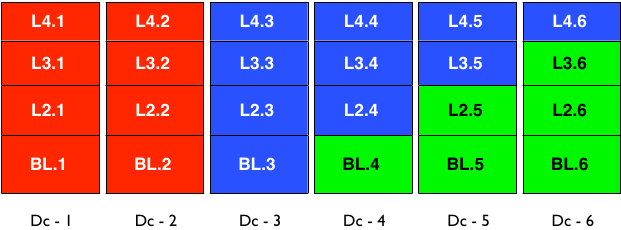
Figure 2. An example of a four-layered SVC stream encoded as ALD, with an STF value of 2 (red denotes additional ALD descriptions, which contain existing SVC data).